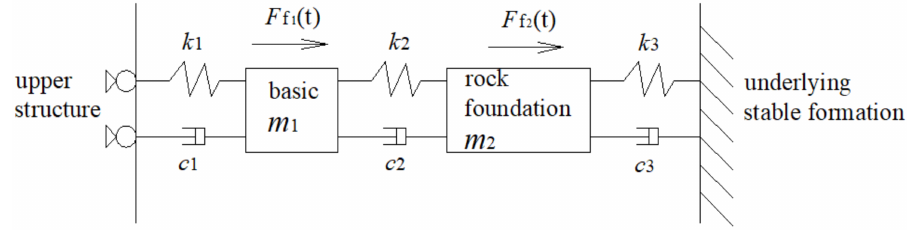
Figure 1. Forced vibration of